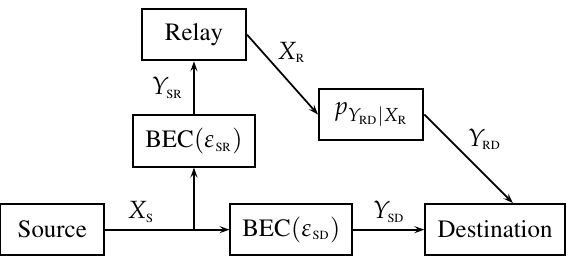
Figure 3. The erasure relay channel: primitive relay channel in which the link from source to relay is a BEC ( ε SR ) and the link from source to destination is a BEC ( ε )